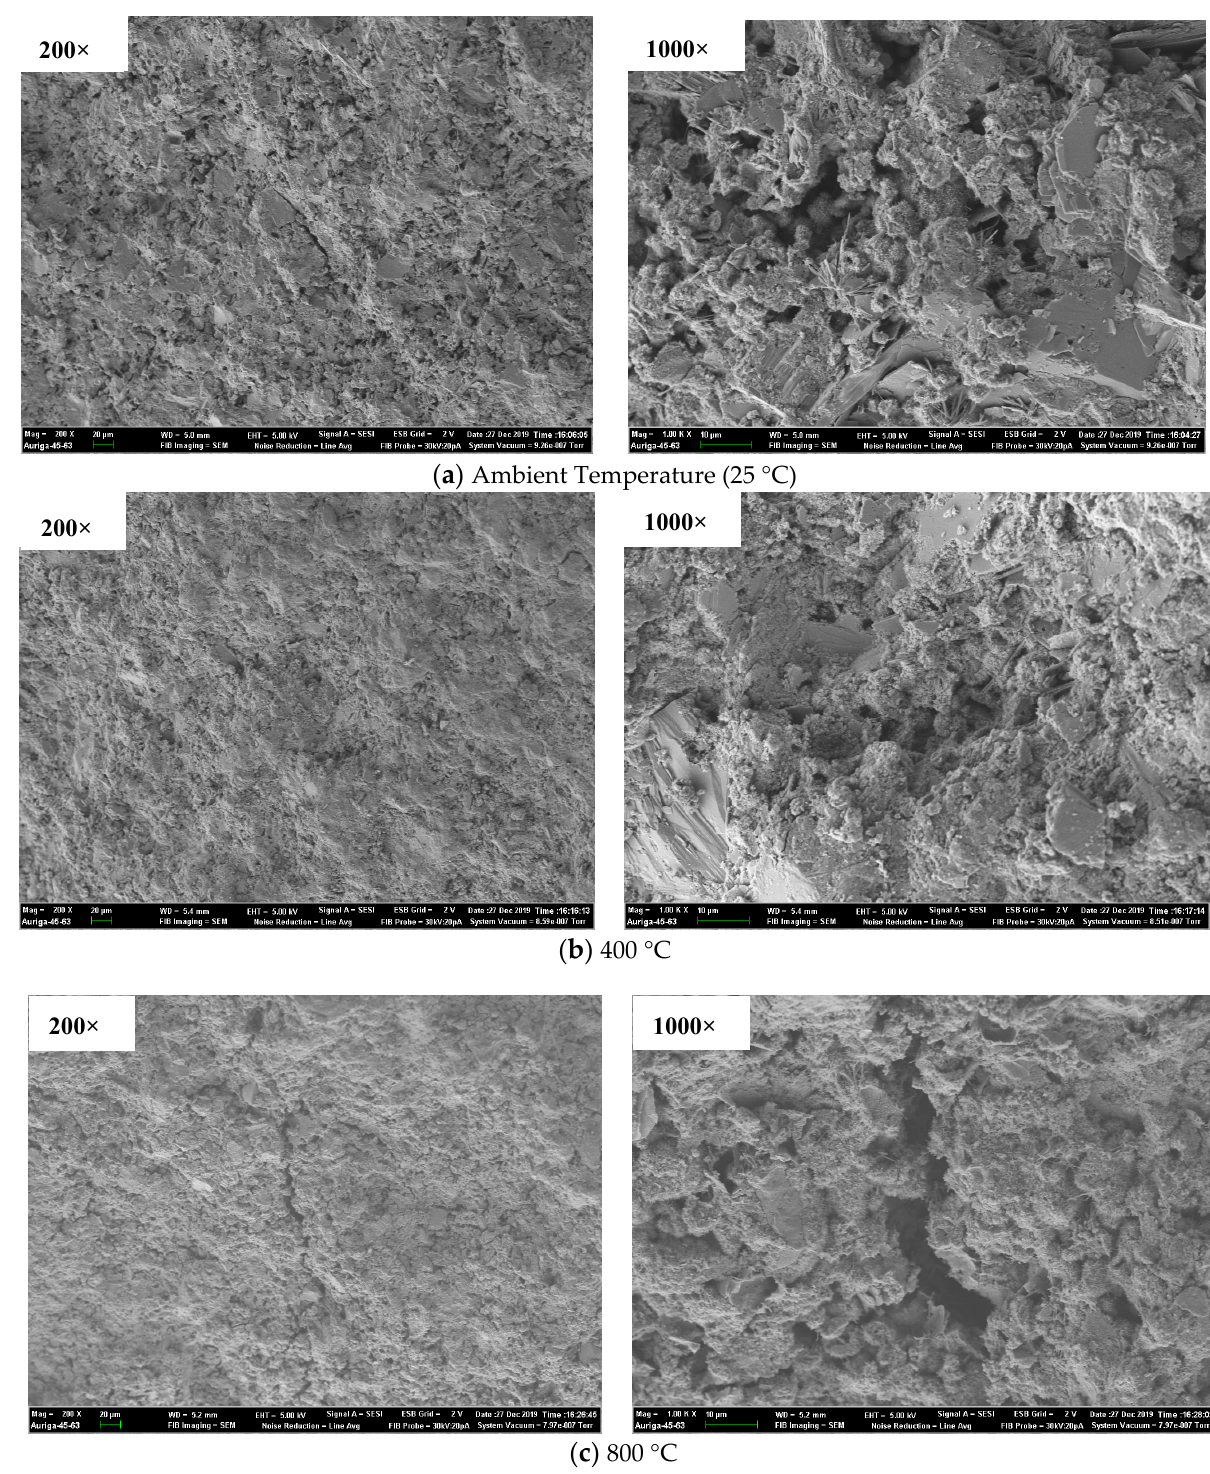
Figure 16. SEM result of GP-C40 after exposure to elevated temperature.